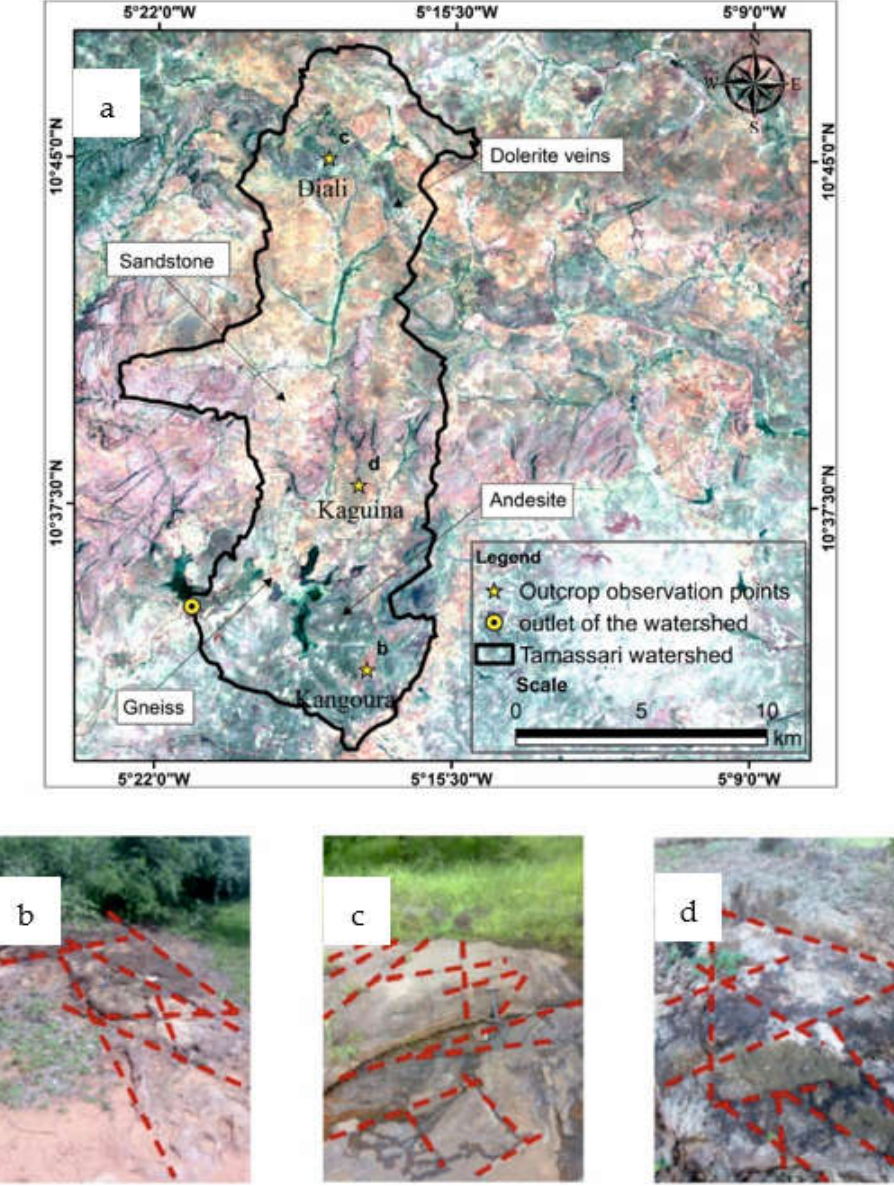
Figure 12. ( a ) Location of the outcrops on the colour composite of bands 7, 2 and 1 of the Landsat 5 TM images; ( b ) Kangoura fractured sandstone; ( c ) Diali fractured dolerite; ( d ) Kaguina fractured gneiss.